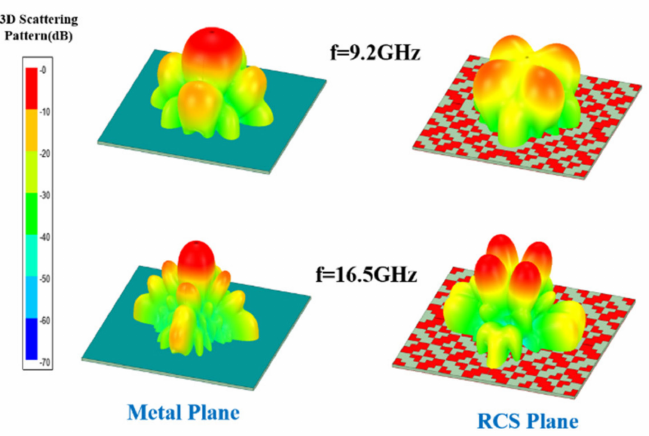
Figure 8. 3D scattering field of metal plane and RCS plane at 9.2 GHz and 16.5 GHz.